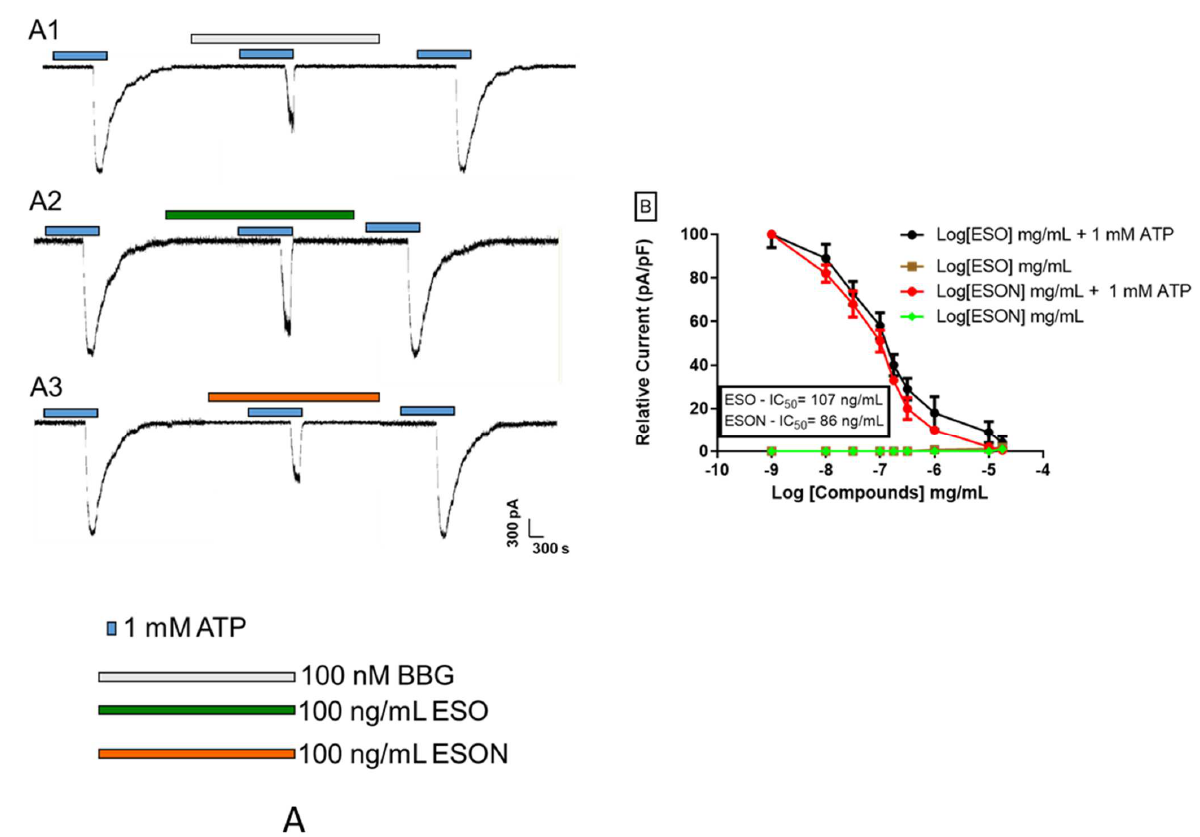
Figure 5. Dose–concentration curves for ESO and ESON inhibition on large-conductance channel activity. ( A ) Whole-cell macroscopic currents recorded P2X7R activated by 1 mM ATP for 5 min at 30–37 °C on MPM. The reversibility of the inhibitory effect of 1 mM ATP for 5 min followed by perfusion of concentrations of ESO, ESON, or 100 nM BBG. After the washout, another pulse of 1 mM ATP was applied; ( B ) the plot represents the quantification of the data observed in A1 – A3 ); % relative current recorded as a function of the ratio between the amplitude of the ionic current and cell capacitance. Values represent mean + SEM. Profiles are representative of 4–5 different experiments.